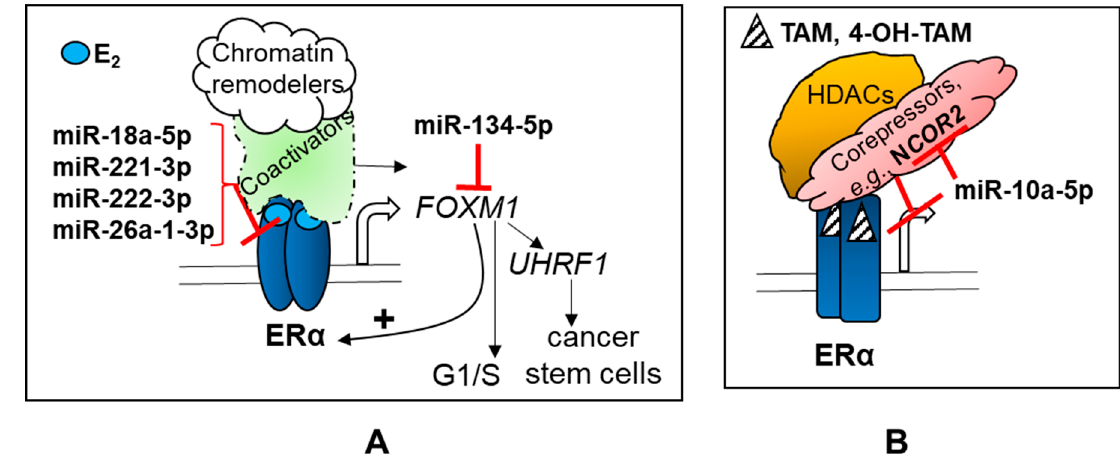
Figure 1. miRNAs regulating ER α transcriptional activity. ( A ) ER α is directly targeted by the indicated miRNAs that are increased in breast tumors (Table 2). E 2 -liganded ER α recruits coactivators and chromatin remodeling complexes to increase RNA pol II transcription at target genes. E 2 –ER α increases the transcription of FOXM1 , which, in turn as a transcription factor, increases the transcription of ER α , including a number of genes for cell cycle progression [224], and UHRF1 , which is a key regulator of DNA methylation that is involved in the self-renewal and differentiation of cancer stem cells [225]. ( B ) The selective ER modulator (SERM) tamoxifen is metabolized to 4-